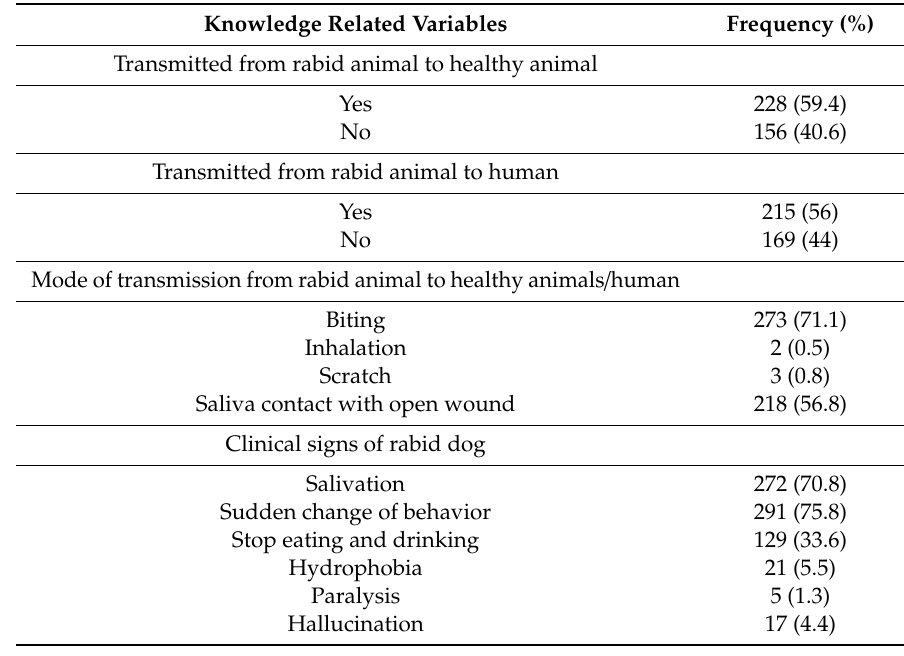
Table 3. Knowledge of the study participants about transmission and clinical sign of rabies (N = 384),